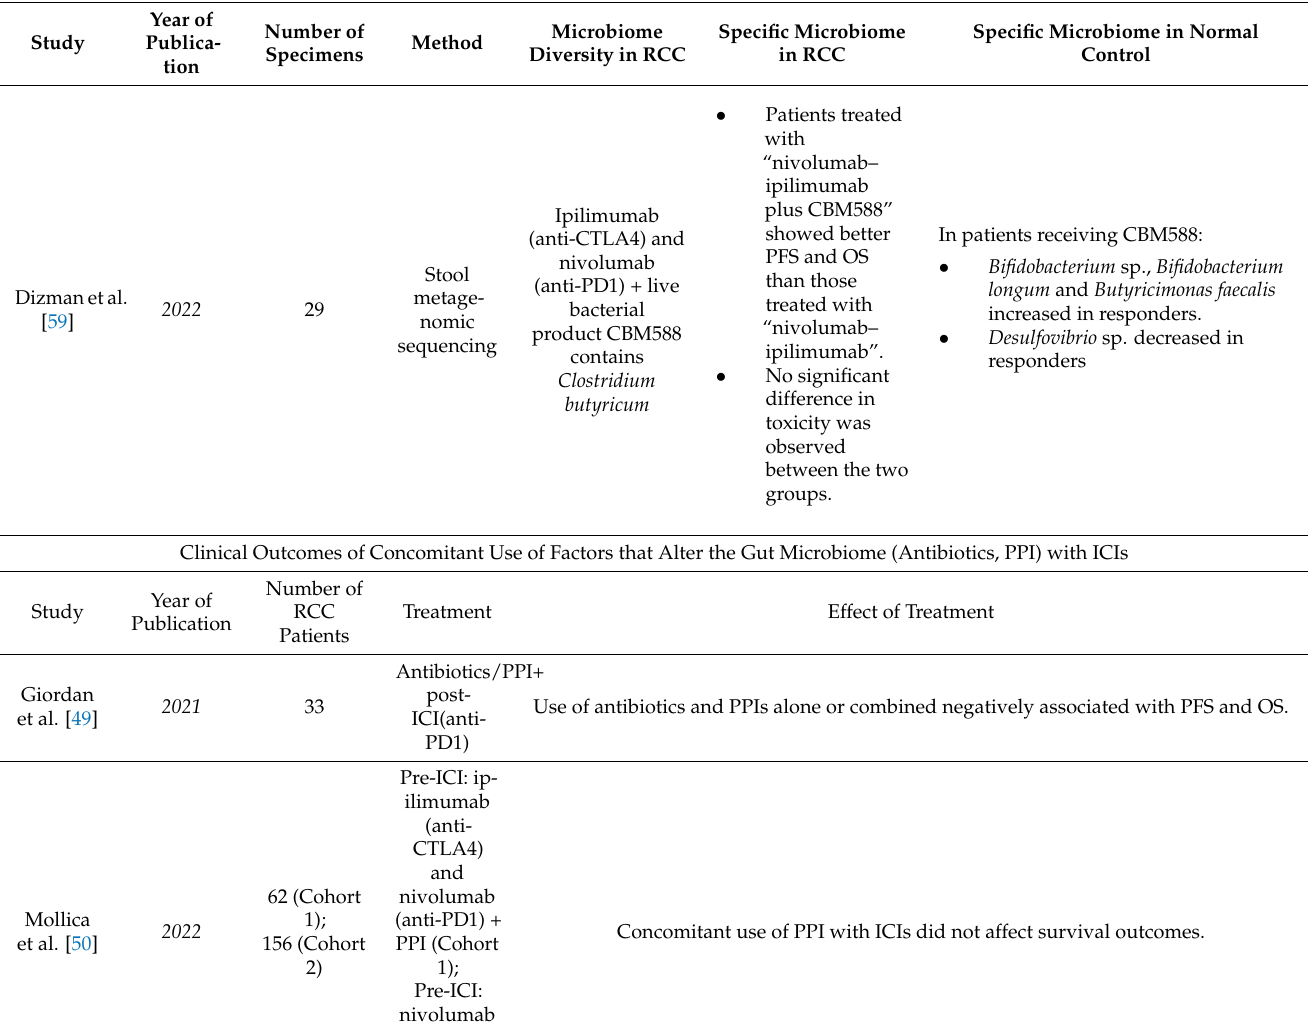
Table 1. Cont. Different Microbiome in Normal and RCC